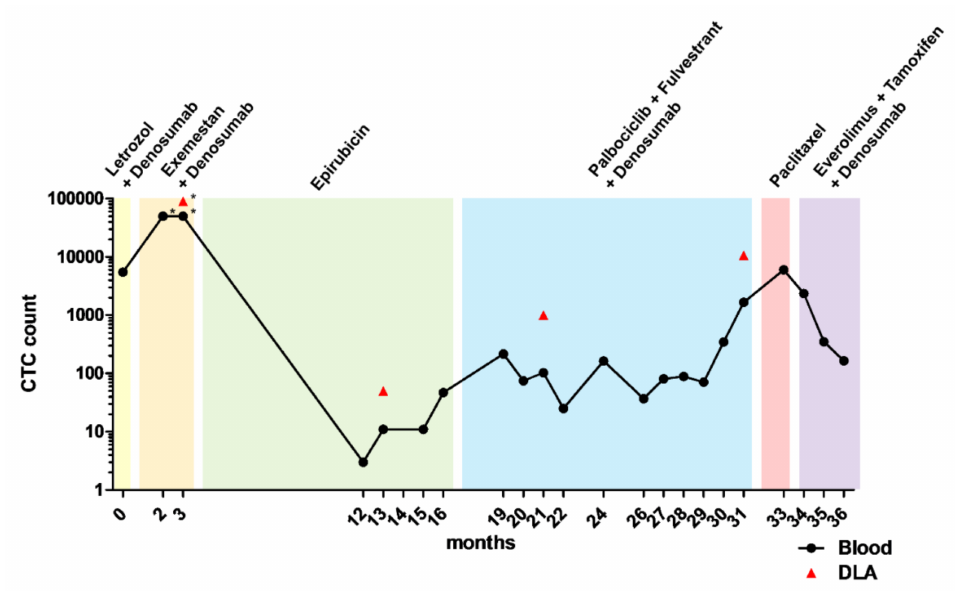
Figure 2. Circulating tumor cell (CTC) count dynamics of patient 1 during the course of the disease. CTCs from patient 1 were counted from 7.5 mL blood or 2 mL diagnostic leukapheresis product (DLA) using the CellSearch system. Each color indicates the duration of a different line of therapy. Time point T0 corresponds to the first presentation of the patient to our department, approximately seven years after the resection of the primary tumor. *The CTC count exceeded the CellSearch detection range. CTC count was estimated by